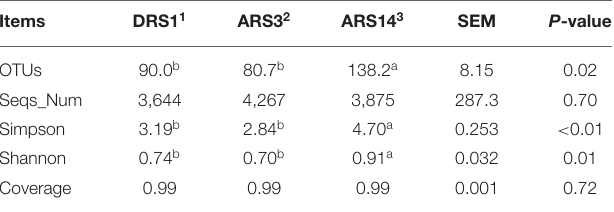
TABLE 3 | The results of α diversity of microbes in rumen fluid after fistula surgery in sheep.